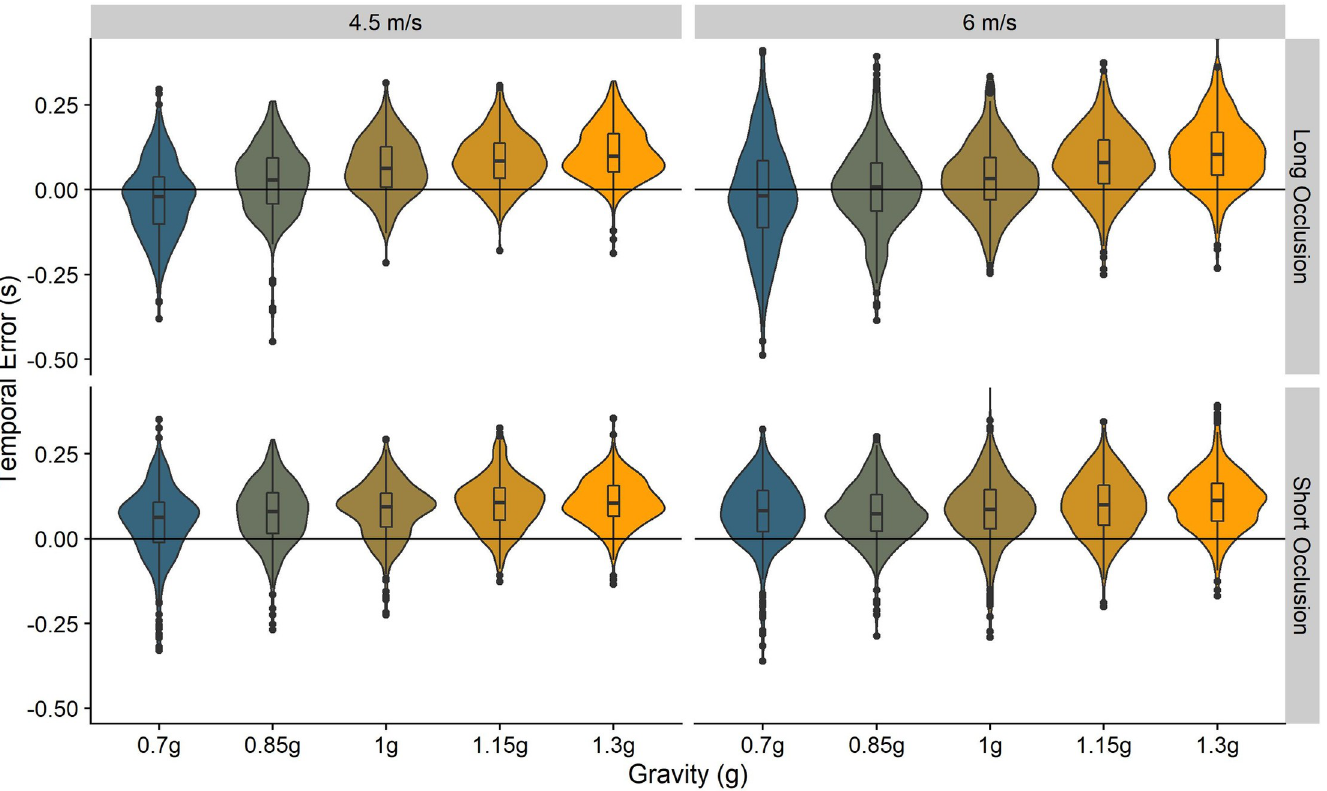
Fig 3. Temporal errors in the 0.7–1.3 g conditions. The wings of each structure indicate the distribution of responses, while the boxplot in the middle of each structure indicate the 75% percentiles and the mean per condition.